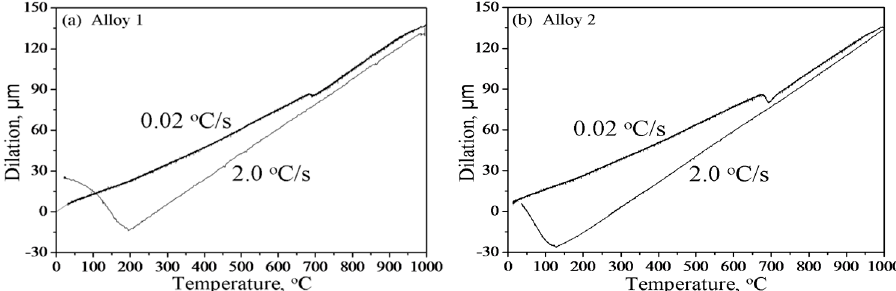
Figure 3. Dilatational strain as a function of temperature: ( a ) Alloy 1, and ( b ) Alloy 2.